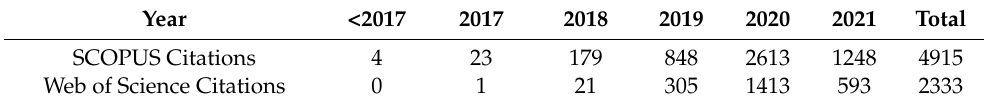
Table 2. Comparative yearly citation